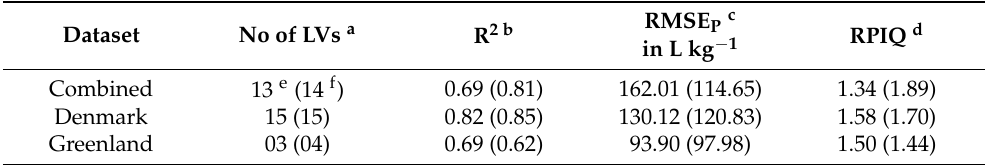
Table A4. The summary of validation results for the best PLSR and ANN calibration models of each